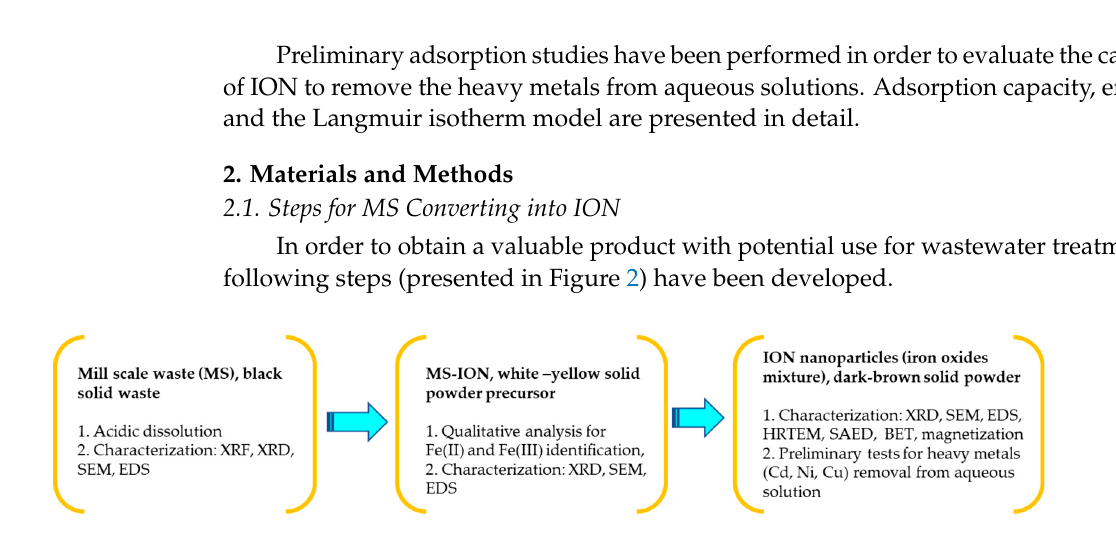
Figure 2. Steps involved in MS conversion into ION, characterization and evaluation as nanoad- sorbents.